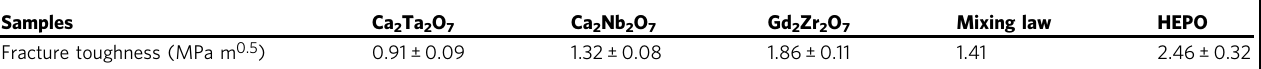
Table 1 Fracture toughness of starting materials, HEPO, and calculated value of mixing law.